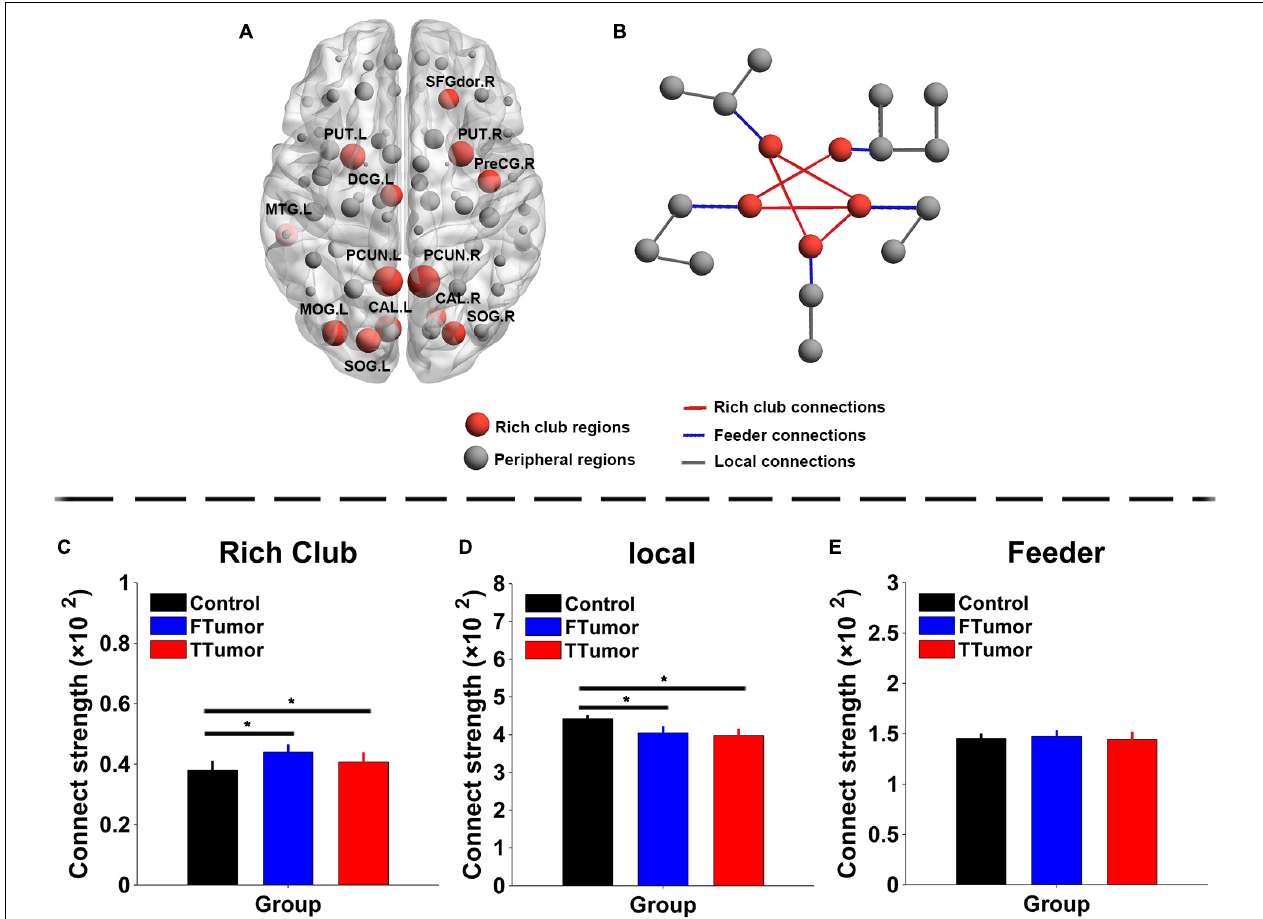
FIGURE 6 | Rich-club regions and rich-club organization of WM structural networks. (A) Brain red nodes showing rich club members across all subjects (both healthy and patients). (B) A simplified example of the three classes of connections. Red lines represent rich-club connections linking two rich-club nodes, blue lines represent feeder connections linking one rich-club node to one peripheral node, and gray lines represent local connections linking two peripheral nodes. (C–E) Bar graphs display the mean (standard error) age-, gender-, and education level-adjusted connectivity strengths for rich club, feeder, and (C) local. FTumors, frontal tumors; TTumors, temporal tumors; WM, white matter; N Lp , nodal shortest path; DC, degree centrality; BC, betweenness centrality; NE, nodal efficiency; ROL.L, left rolandic operculum; SFGdor.R, right superior frontal gyrus, dorsolateral. SFGmed.R, right superior frontal gyrus, medial; MFG.L, left middle frontal gyrus; AUC, area under the curve. * p <